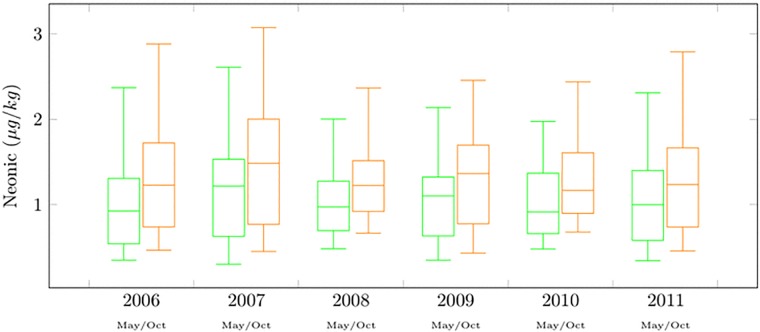
Neonicotinoid concentrationsw.The box-plots provide information about neonicotinoid concentrations levels in nectar from all areas sampled, pooled according to years and seasons. Green and orange lines refer to spring and autumn seasons, respectively.